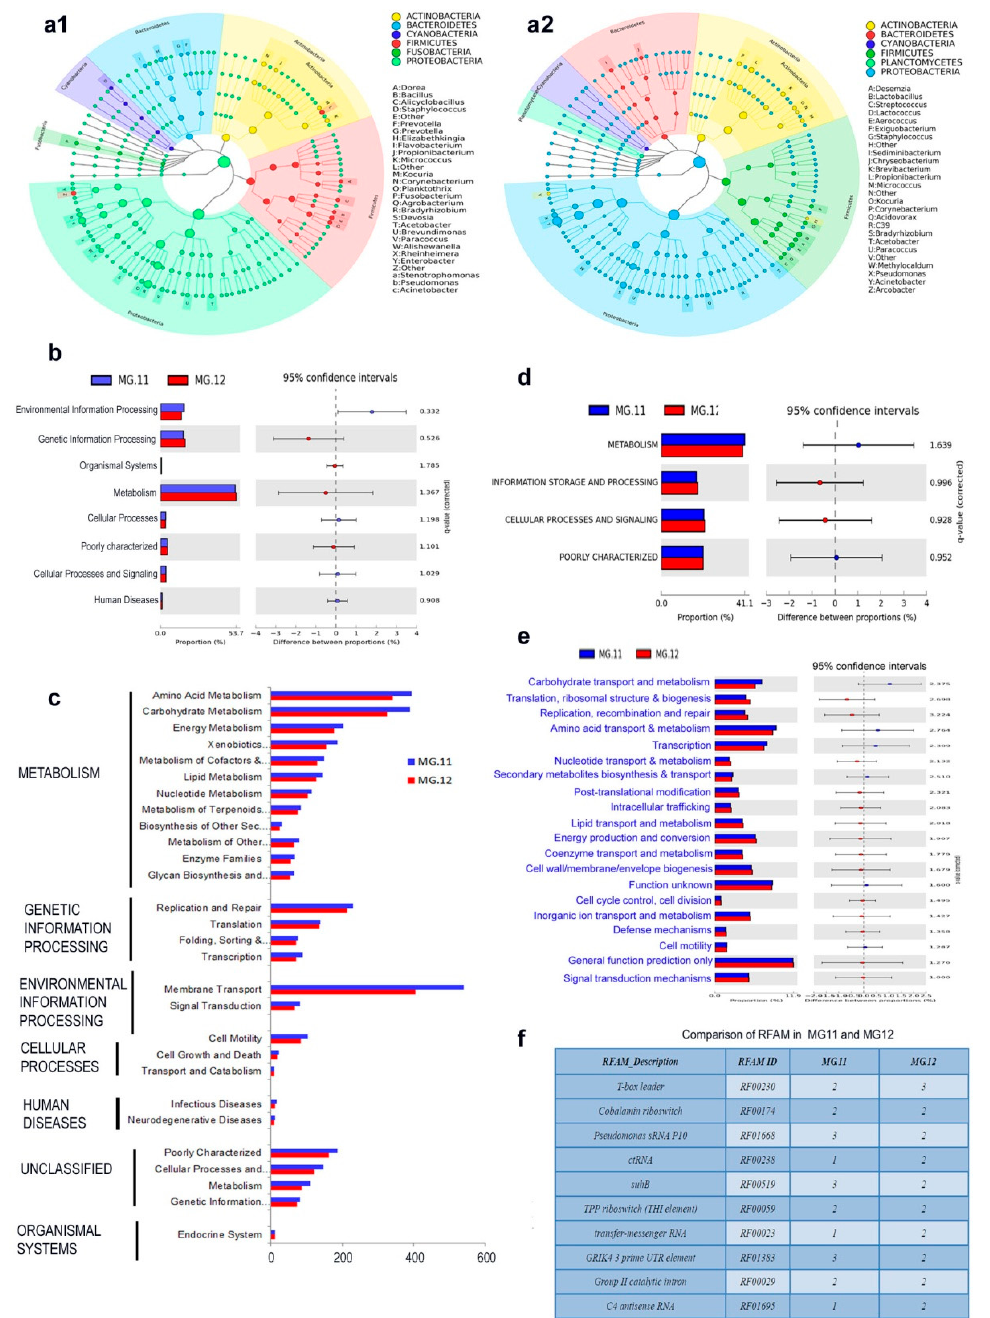
Figure 9. PICRUSt mediated endophytic bacterial functional analysis on 16S rRNA metagene V3–V4 profiled FC01 grape callus. ( a1 , a2 ) Cladogram showing the taxonomic diversity from phylum to genus level based on defined genera in “Gamay Fréaux” MG11 and MG12 samples, ( b ) functional analysis based on KEGG pathway Level 1 and ( c ) Level 2, ( d ) COG-based functional analysis at Level 1 and ( e ) Level 2 and ( f ) R-FAM analysis in MG11 and MG12.